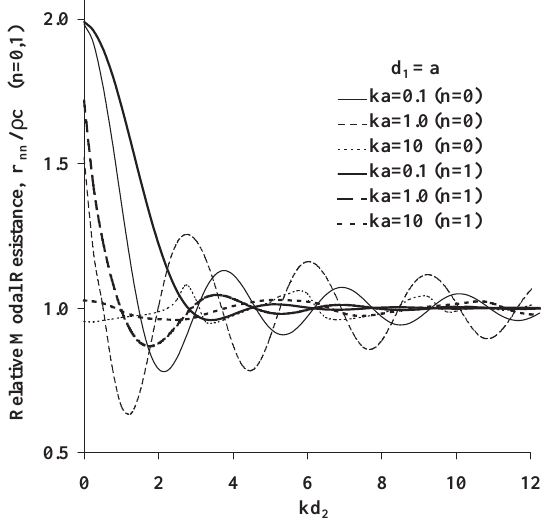
Fig. 6. Relative acoustic resistance for a pulsating and an oscillating source placed near the rigid boundary of an acoustic quarterspace at d 1 = a as a function of the separation parameter, kd 2 , at selected excitation frequencies.